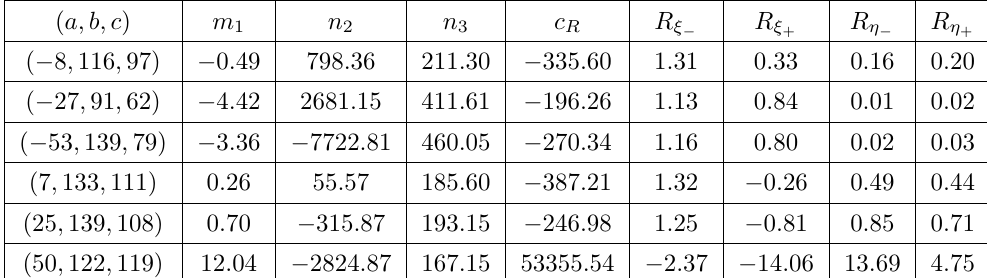
Table 2 . Values of m 1 ; n 2 ; n 3 (divided by C ), c geo = c sugra (divided by CN 2 ) and the R-charges R (divided by N ) for certain triples a; b and c: The triples with negative a correspond to globally well-de(cid:12)ned solutions; note that C < 0 and therefore the central charges are positive. The triples with positive a always have at least one negative